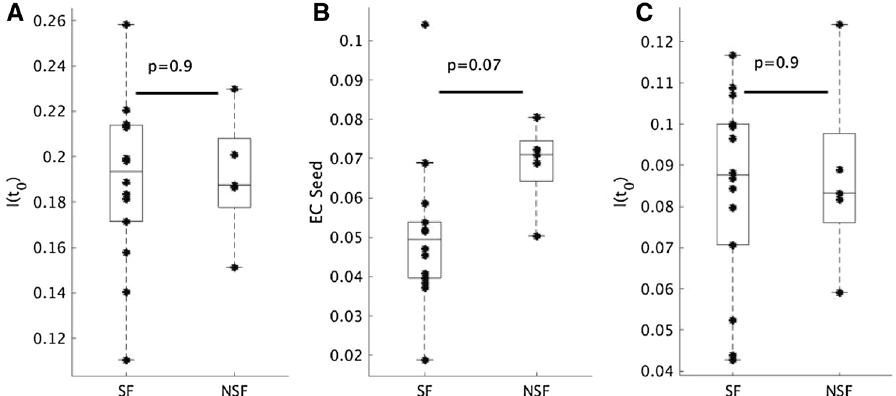
Figure 6. Seizure-free (SF) compared to not seizure-free (NSF) patients. ( A ) The seizure propagation as measured by I(t 0 ) before the virtual resection was not different between the SF ( n = 14) and NSF ( n = 5) patient groups. ( B ) The EC of the seed (which is equal to EC difference for a full resection) was marginally larger